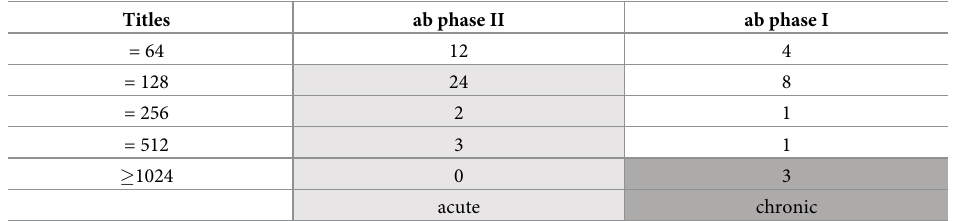
First highlight: patients with titers and antibodies indicative of acute disease Second highlight: patients with titers and antibodies indicative of chronic